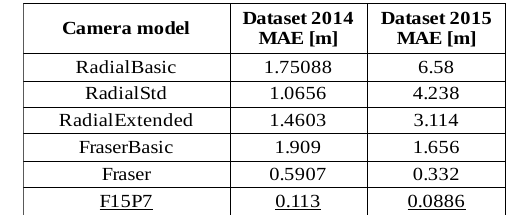
Table 1: Description of the basic distortion models easily accessible in MicMac. Experimented users can define their own camera model as well as the way to liberate parameters in the bundle adjustment.